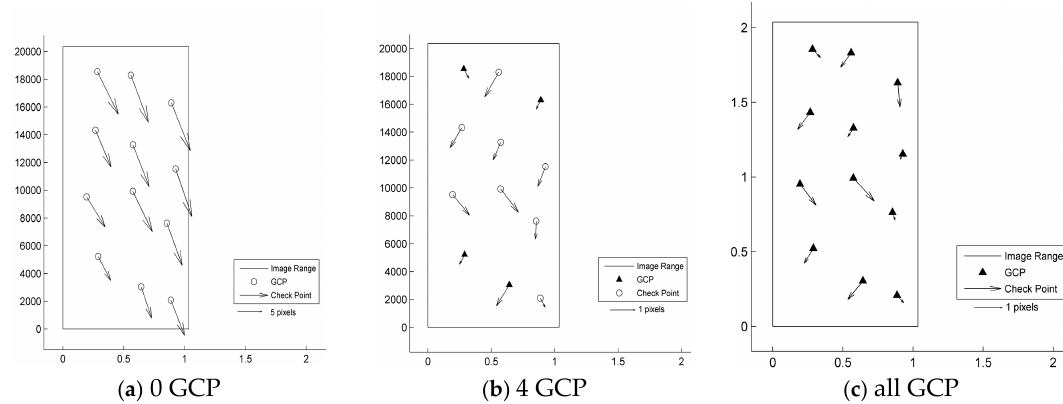
Figure 3. Residual distributions of check points of the SL mode orientation for Taiyuan. ( a ) 0 GCP; (b ) 4 GCP; ( c ) all GCP.